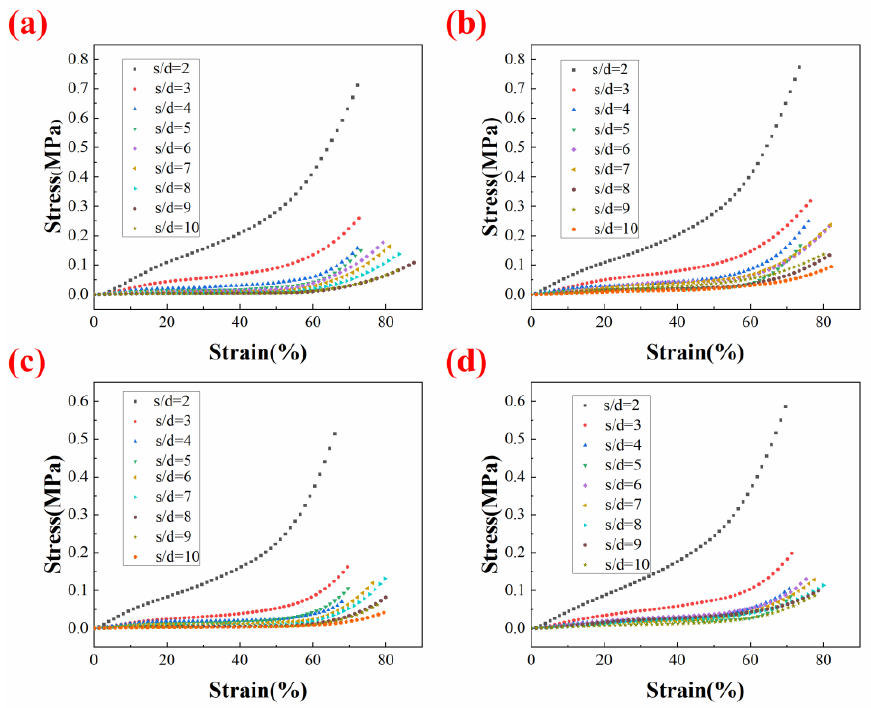
Figure 13. Compression stress–strain profiles of s/d = 2–10 samples at ( a ) room temperature substrate; ( b ) 90 °C substrate; ( c ) 120 °C substrate; ( d ) 150 °C substrate.